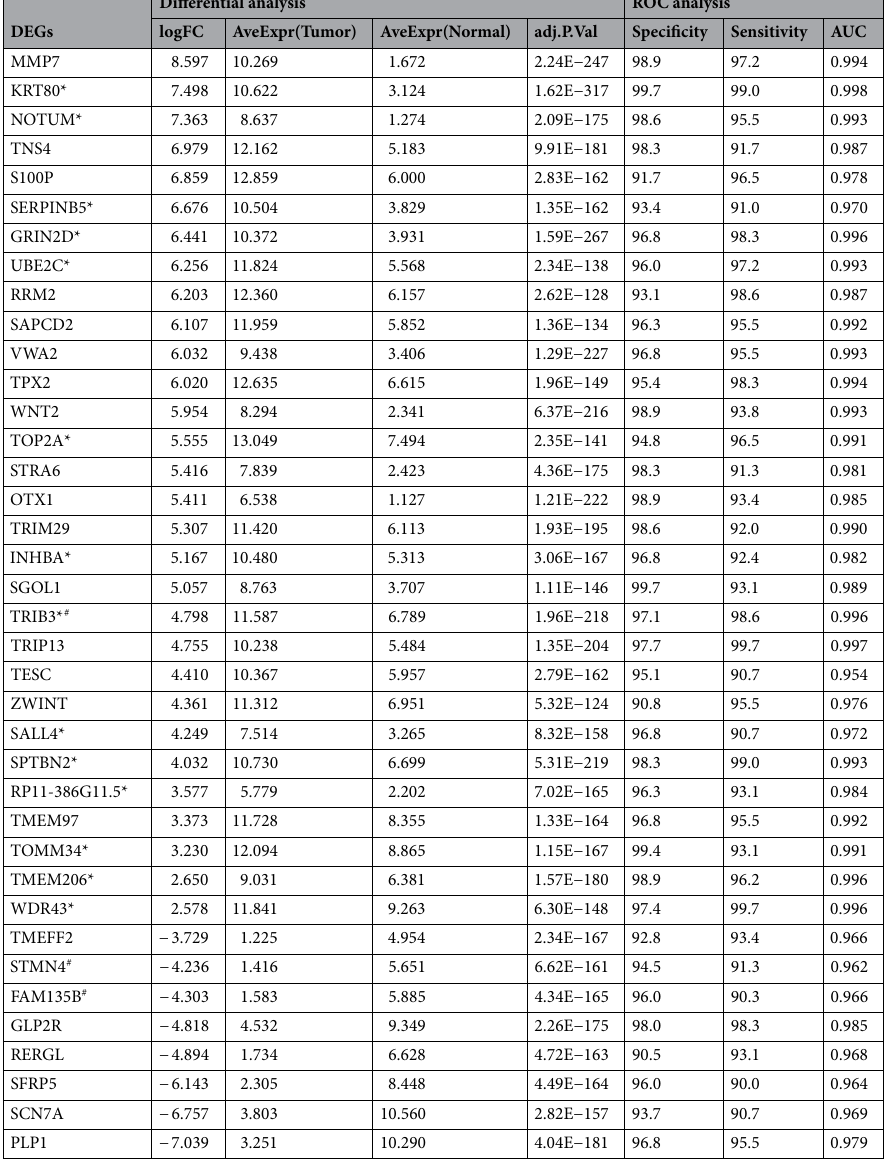
Table 2. Differential expression and ROC analysis of the 38 candidate DEGs. The differential analysis was performed by limma “package” in R. ROC analysis was carried out using MedCalc software. Genes with “*”showed the tumor stage-positive related genes ( P < 0.05). Gene with “#”showed the survival-related genes ( P <